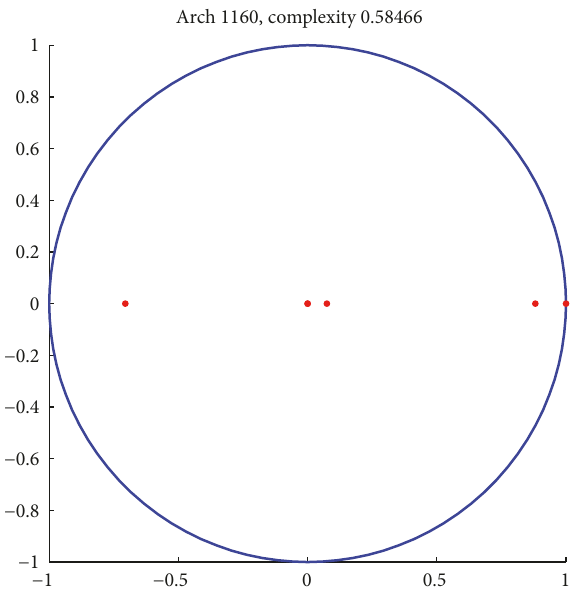
Figure 11: Eigenvalues for low complexity architecture.